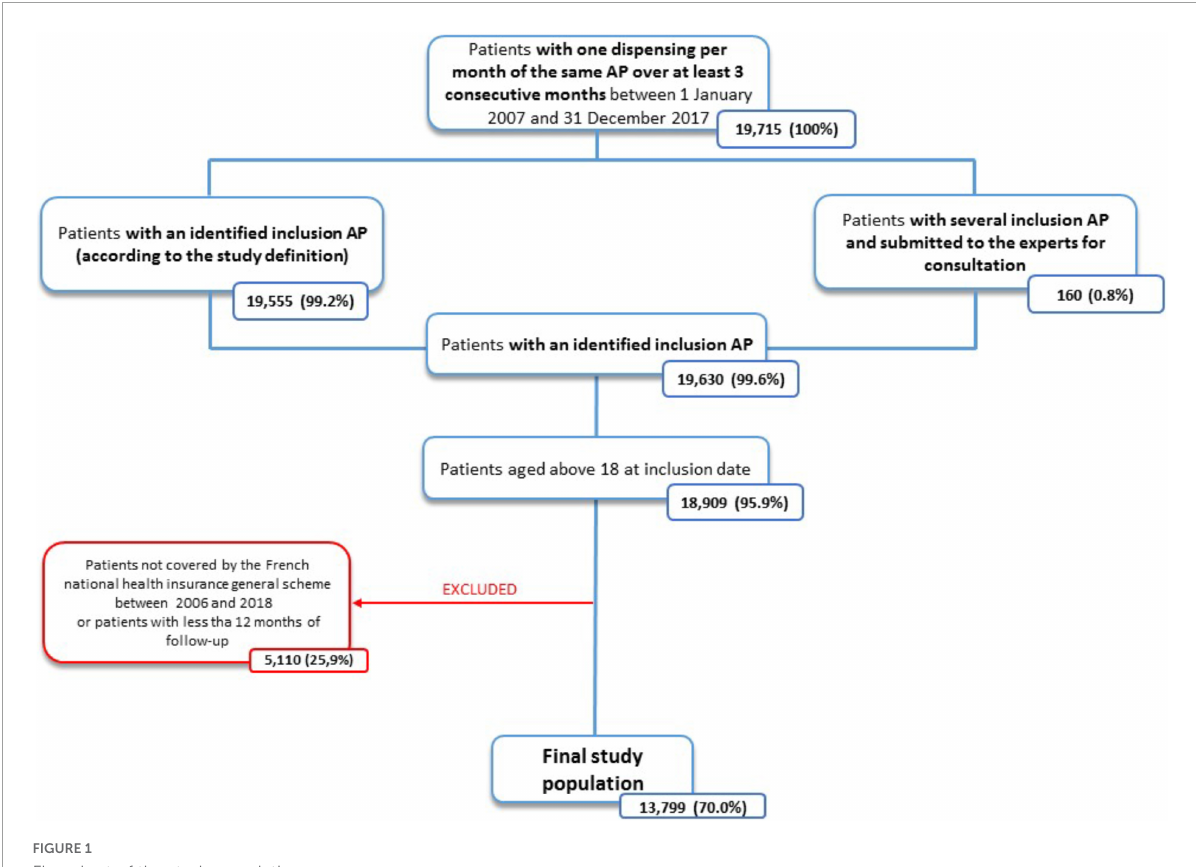
FIGURE1 Flowchart of the study